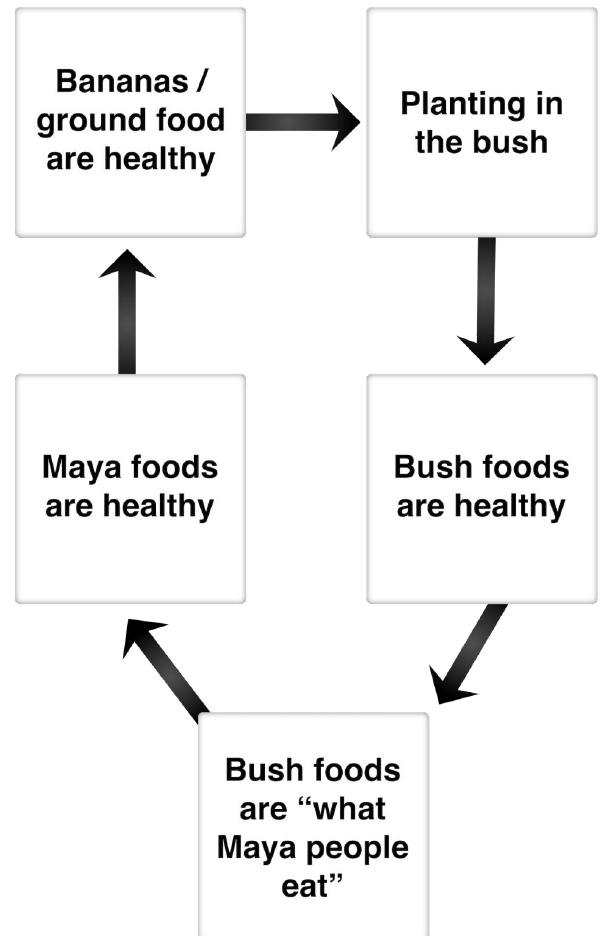
Figure 1. Phenomenological processing loop: Bananas as